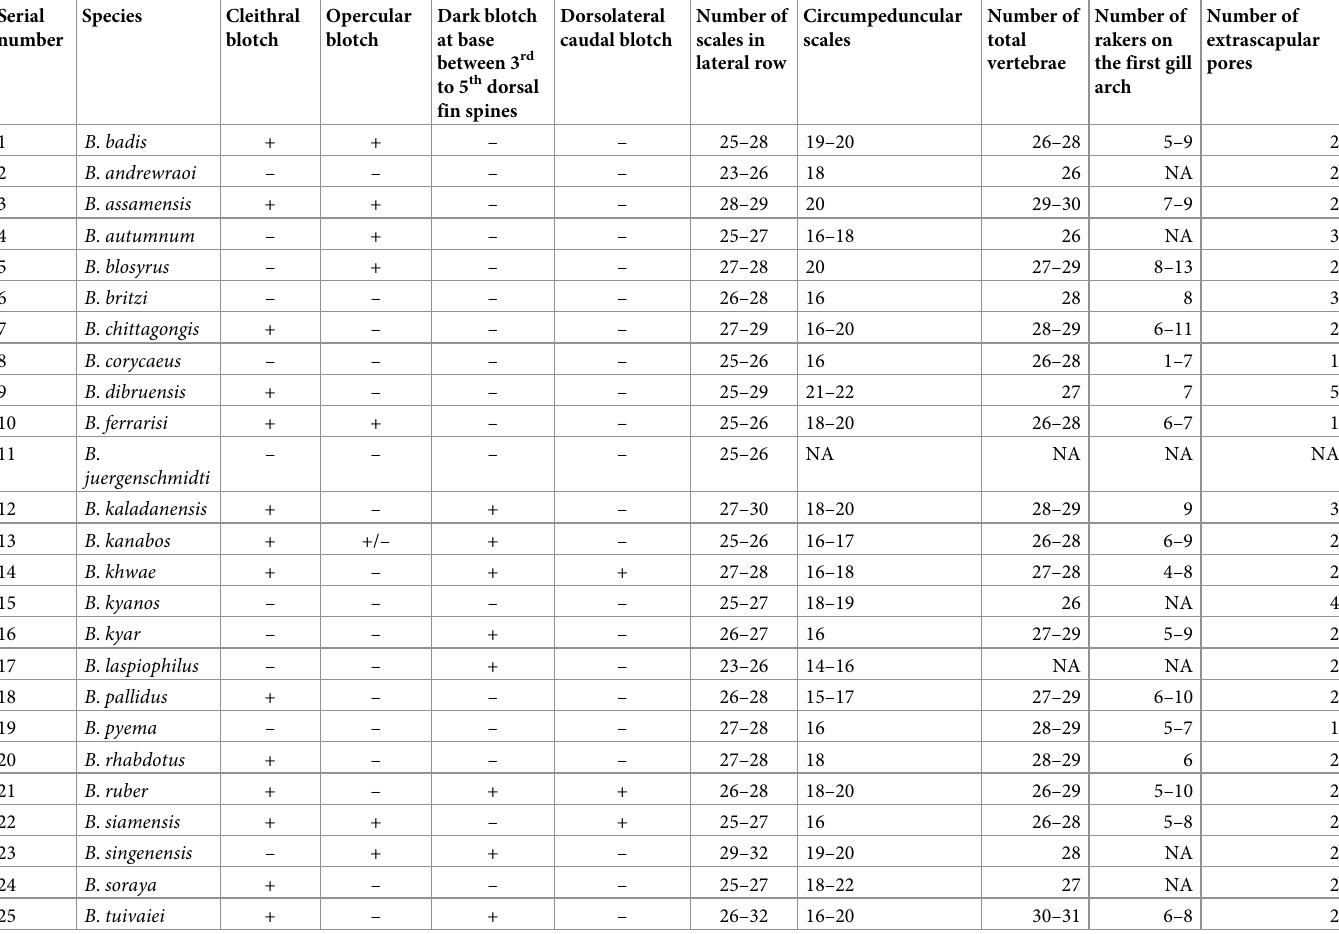
Table 3. Comparison of diagnostic characters among Badis congeners. ‘+’ indicates presence and ‘–’ indicates